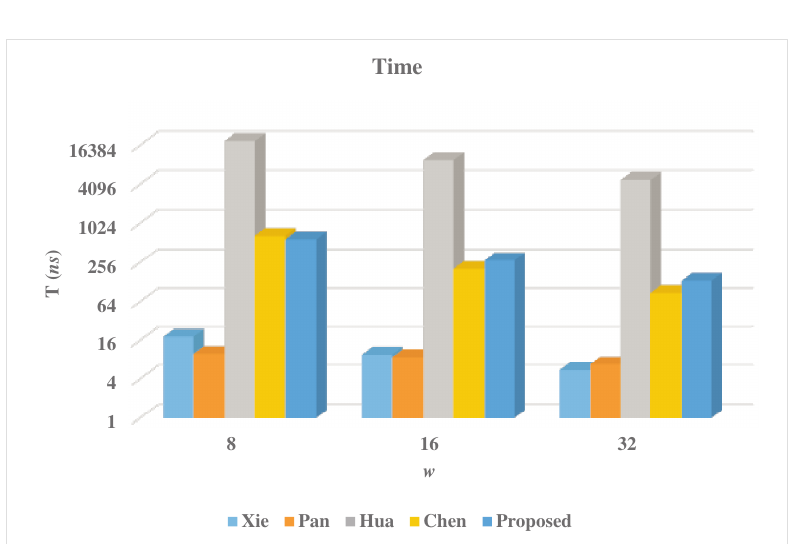
Figure 9. Comparison of area results.